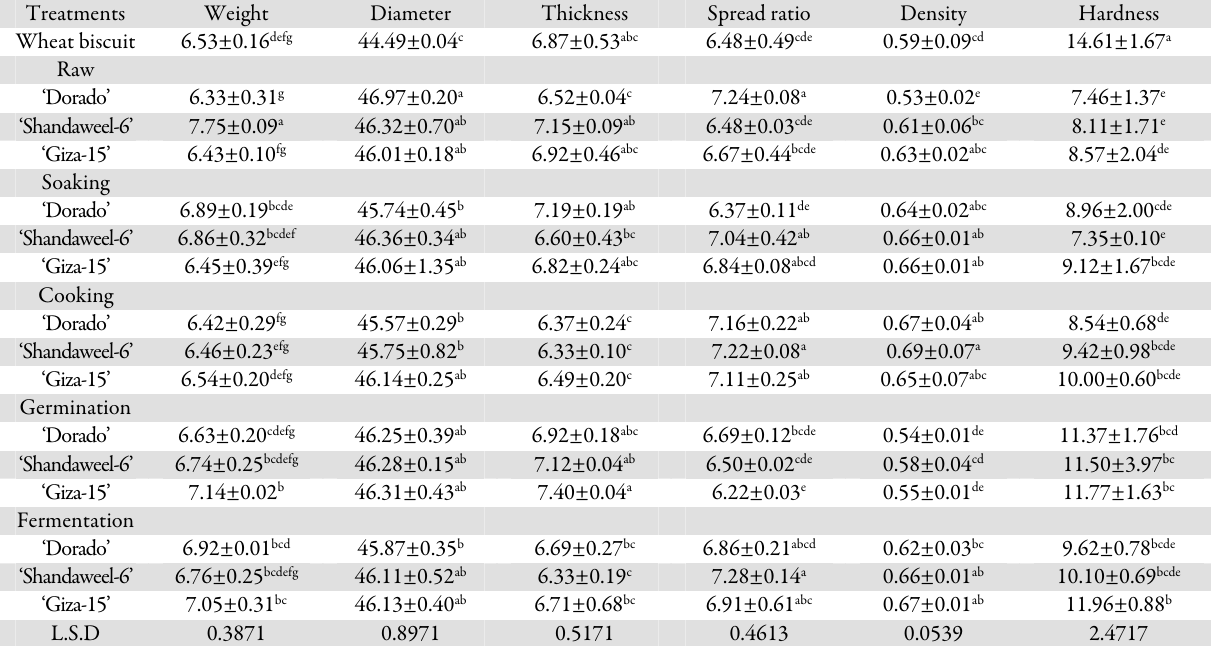
Table 5. Physical properties and hardness of sorghum biscuits Treatments Weight Diameter Thickness Spread ratio Density Hardness Wheat